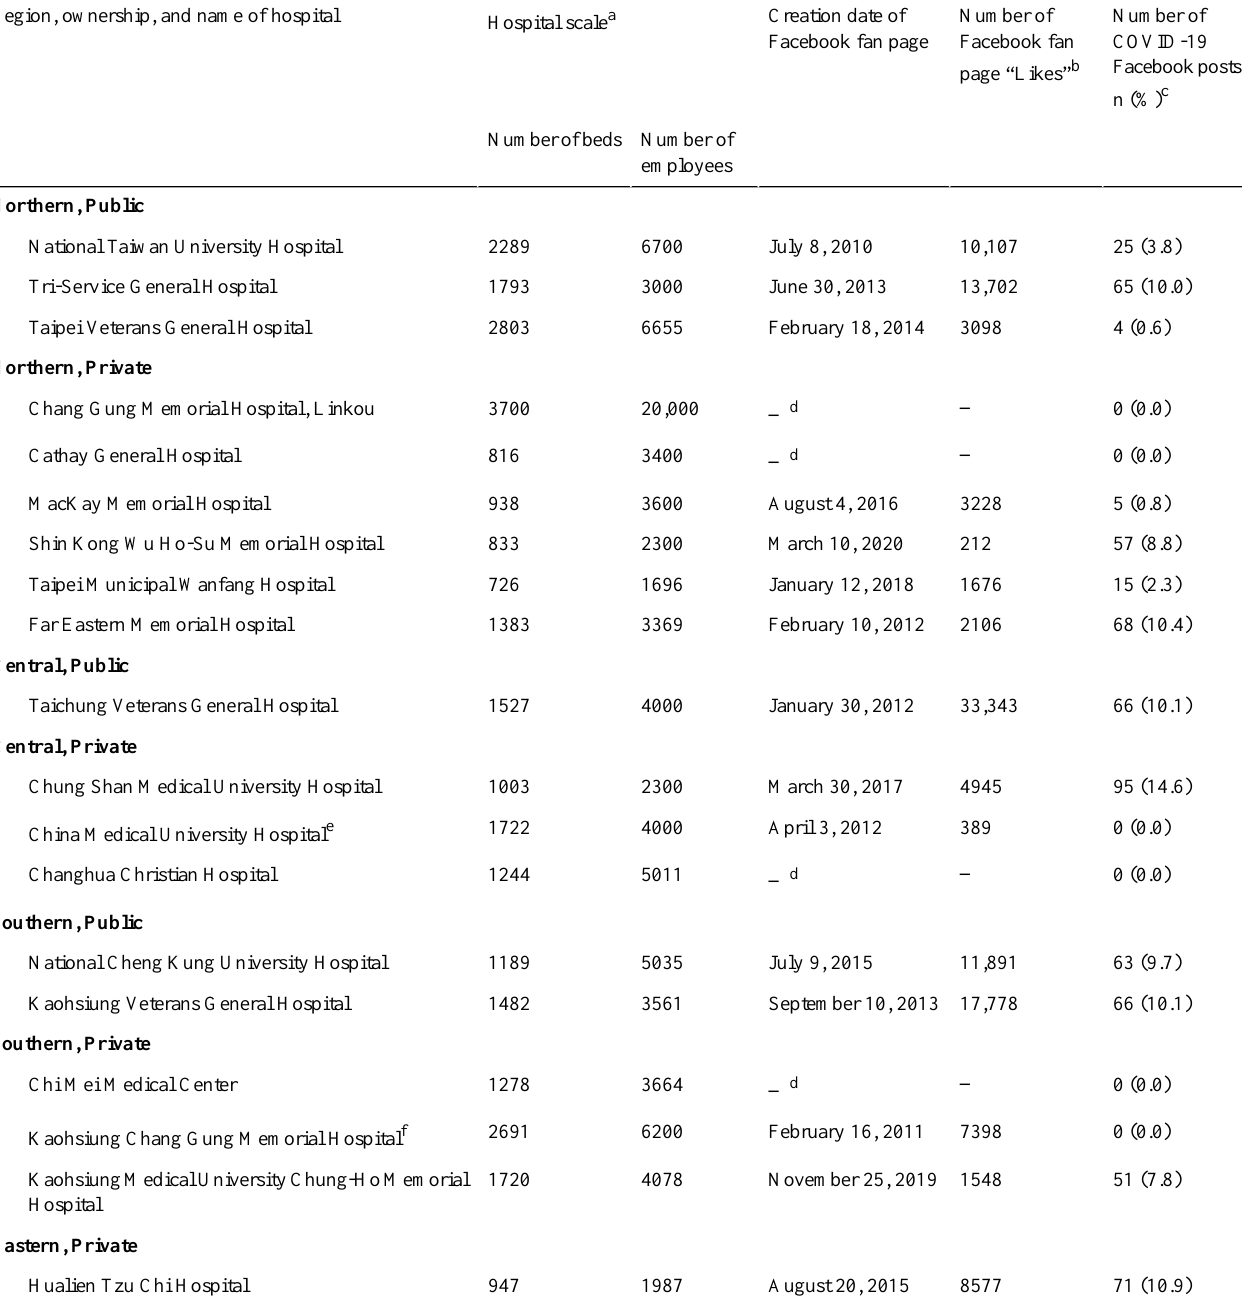
Table 1. Nationwide medical center information and Facebook fan pages in